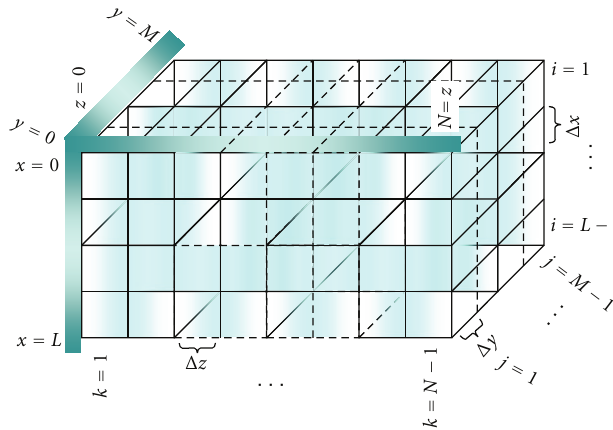
Figure 1: Constructed grid for 3